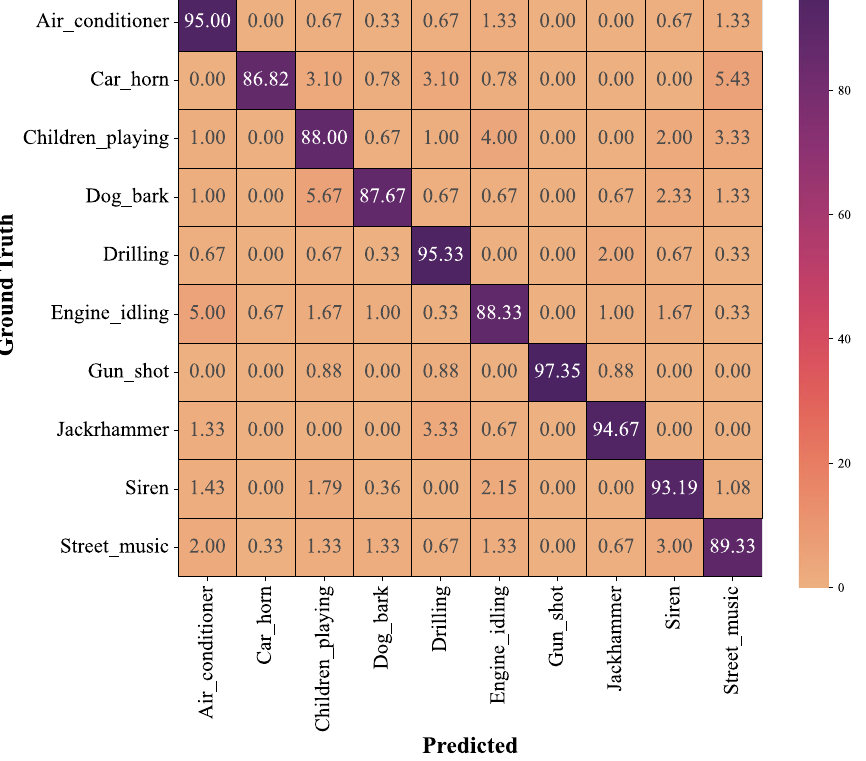
Figure 8. The confusion matrix for the proposed model (CNN-LSTM-Attention-Leaky ReLU) on UrbanSound8K dataset.